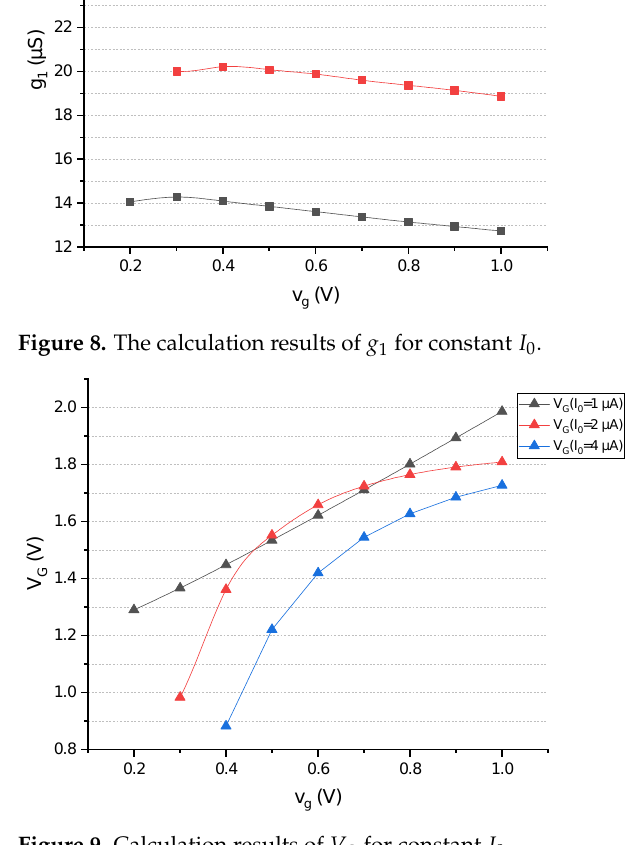
Figure 9. Calculation results of V G for constant I 0